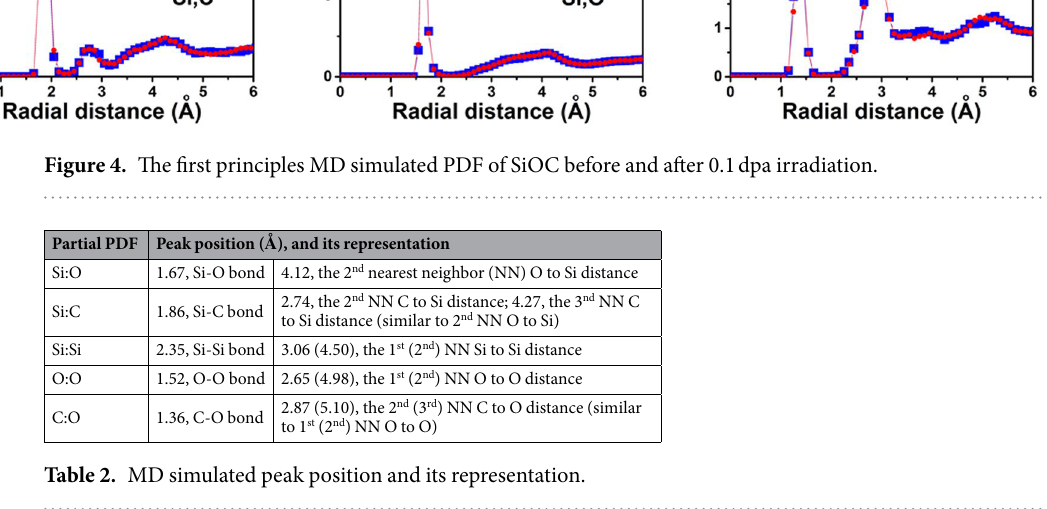
Table 2. MD simulated peak position and its